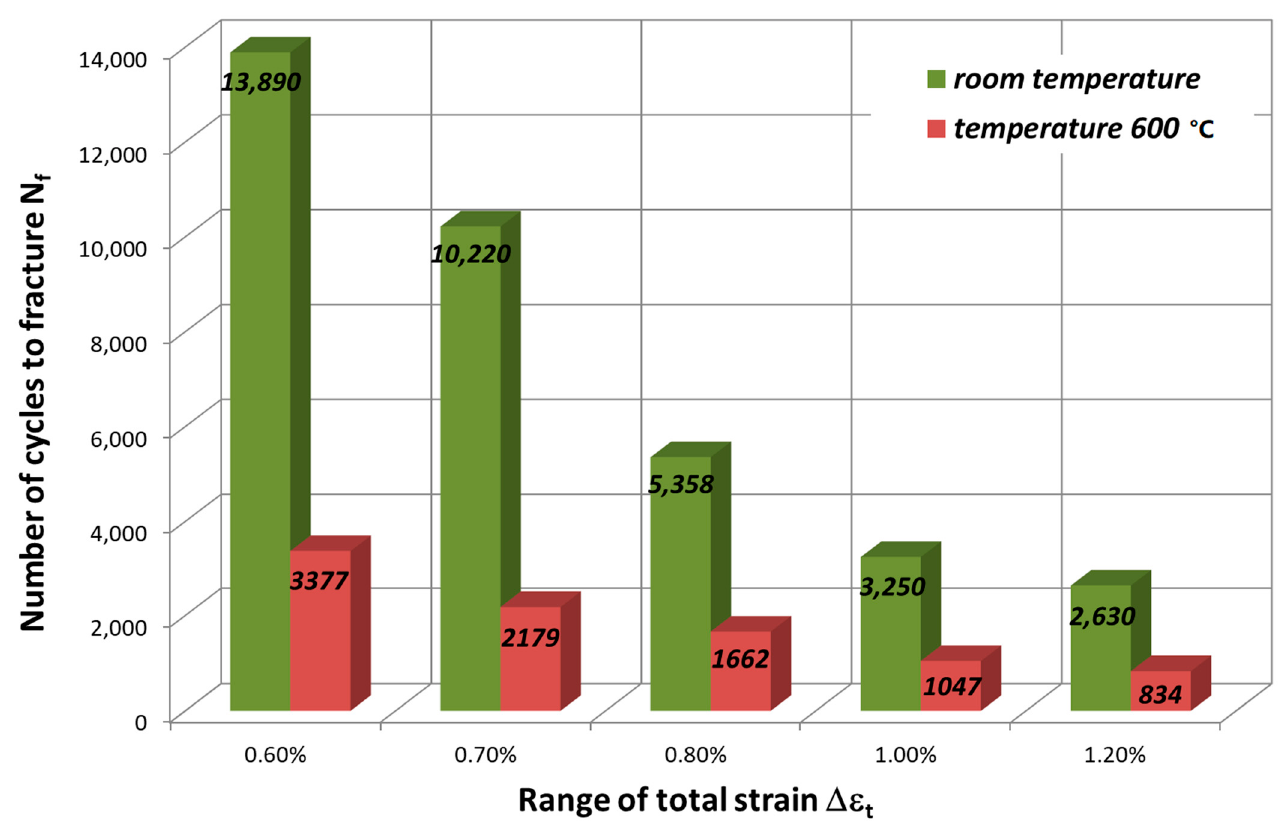
Figure 15. Low-cycle fatigue life N f for HR6W alloy at room temperature and 650 °C.